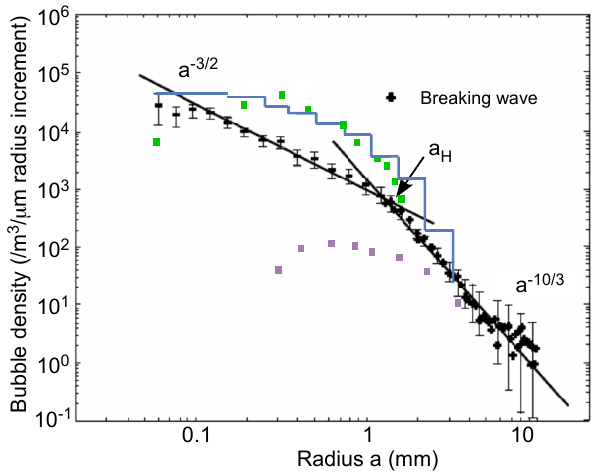
Fig. 1. Bubble size distribution (density vs. bubble radius) in open ocean and laboratory whitecaps. The grey lines show reference power law scalings for bubble distributions. Theoretical considera- tions lead to an a − 10 / 3 power law scaling for bubbles larger than the Hinze scale (approximately 1mm). Bubbles smaller than the Hinze scale are more variable in their power law scaling but roughly fol- low an a − 3 / 2 trend (Deane and Stokes, 2002). Purple squares are Loewen et al. (1995), green, Bezzabotonov et al. (1986) and blue line from Cirpriano and Blanchard